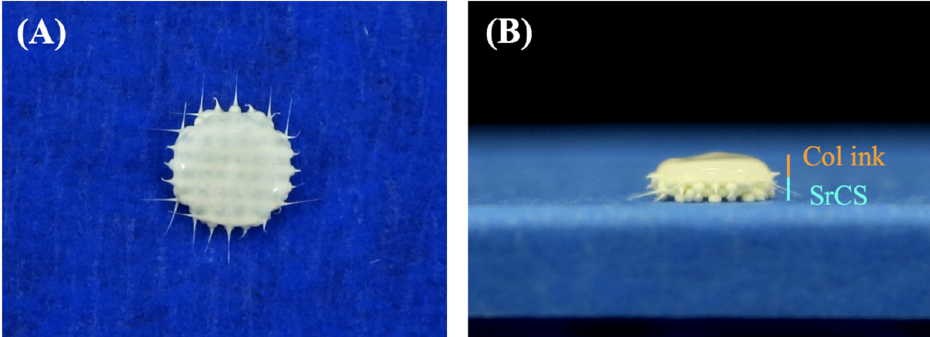
Figure 1. ( A ) Top and ( B ) side view photo images of the Col bio-ink/SrCS bi-layer scaffolds.